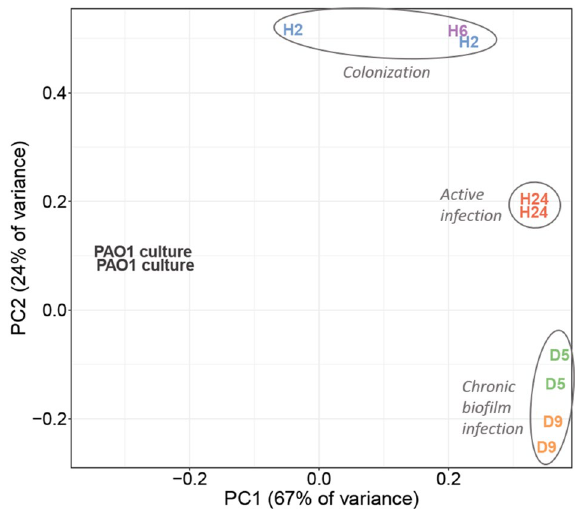
Figure 2. Principal component analysis of transcript counts of PAO1 in log-phase culture and at in-wound times. H2, Hour 2; H6, Hour 6; H24, Hour 24; D5, Day 5; and D9, Day 9.